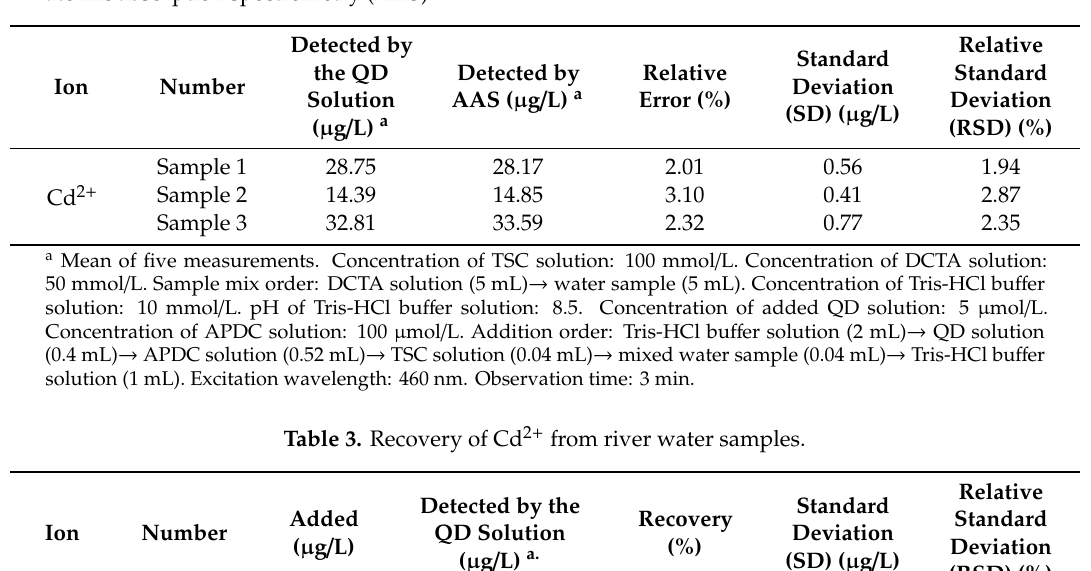
Table 2. Comparison of the detection of Cd 2 + in river water samples using the QD solution sensor and atomic absorption spectrometry (AAS).